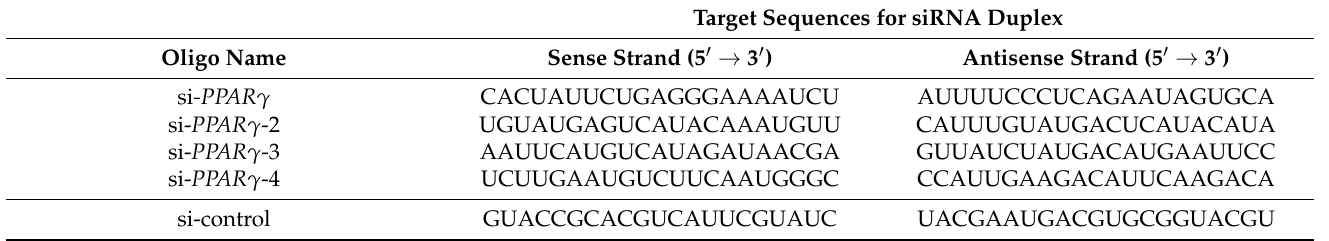
Table A2. Target sequences for siRNA